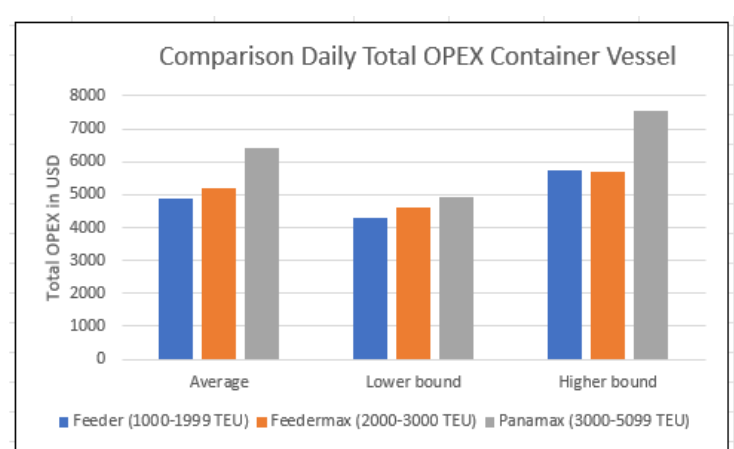
Figure 9. OPEX cost for various container vessels.